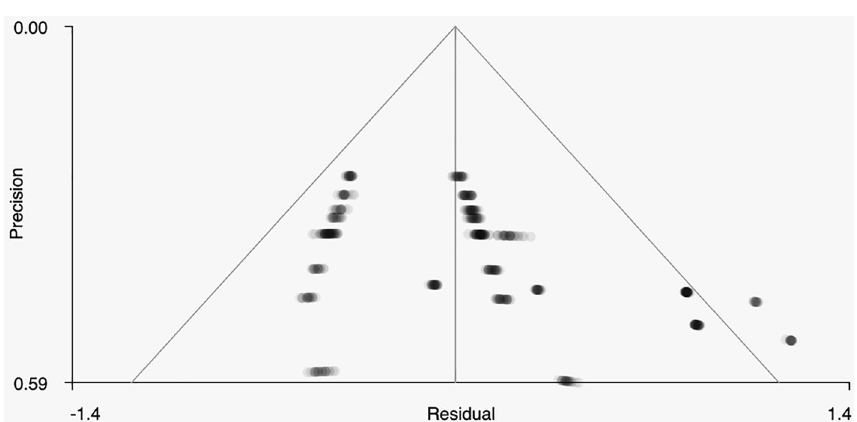
Figure 2. Funnel plot indicating relative symmetry in the scatter of studies based on effect index, i.e., residual (x-axis) and sample size index, i.e., precision (y-axis). Plot symmetry suggests the absence of publication bias due to trial